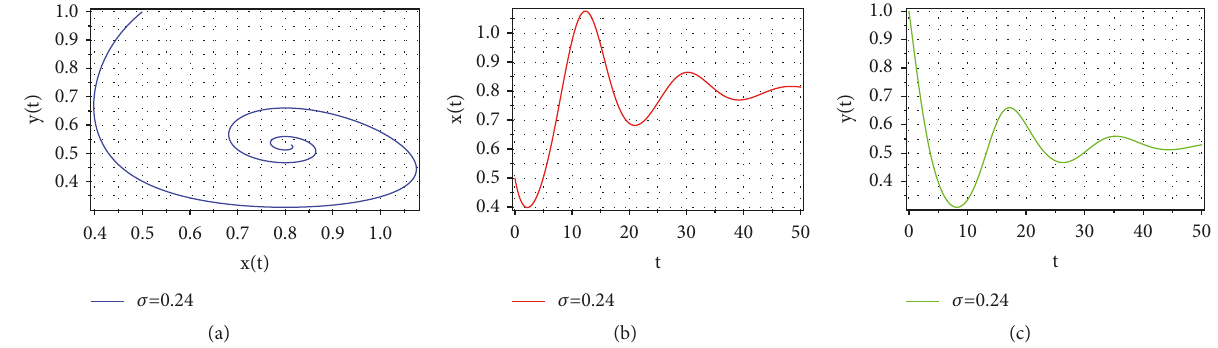
Figure 8: Numerical simulations in case < max {𝑥 ∗ , ℎ 1 } < ℎ 0 < ℎ ≤ ℎ 2 . (a) Phase portrait of 𝑥(𝑡) and 𝑦(𝑡) on ℎ = 1.5 . (b) Time series of 𝑥(𝑡) . (c) Time series of 𝑦(𝑡) .